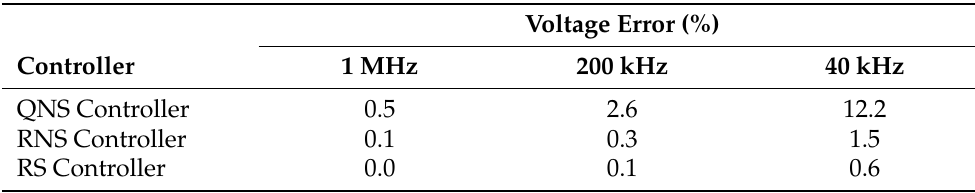
Table 2. Average steady-state